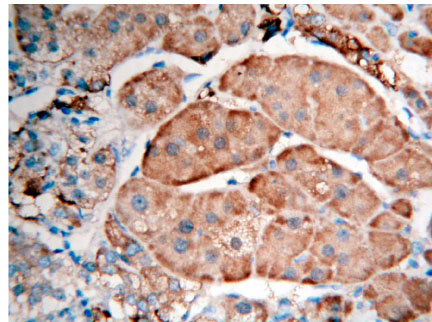
Adrenocortical hyperplasia FHIT ( + + +) SuperisionTM two footworks